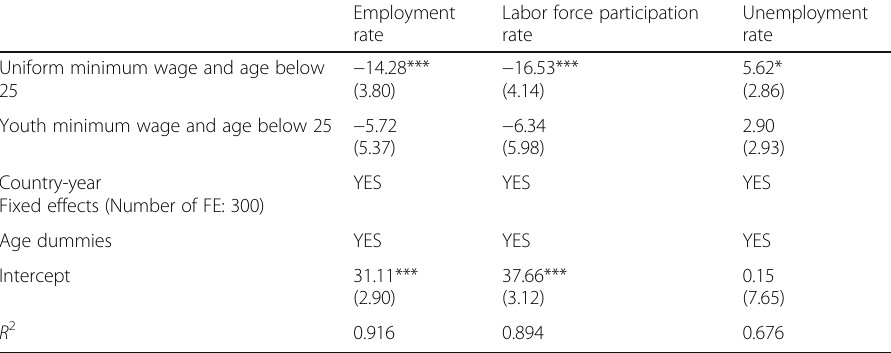
Table 2 Estimation results of model [1]; N = 1740